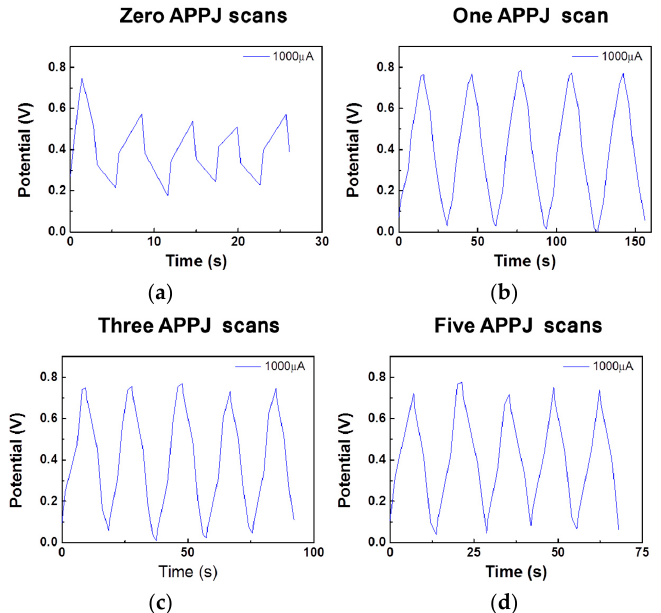
Figure 6. GCD results of gel-electrolyte supercapacitors made with rGO pastes on carbon cloth processed by scan-mode APPJ: ( a ) zero APPJ scans; ( b ) one APPJ scan; ( c ) three APPJ scans; and ( d ) five APPJ scans.